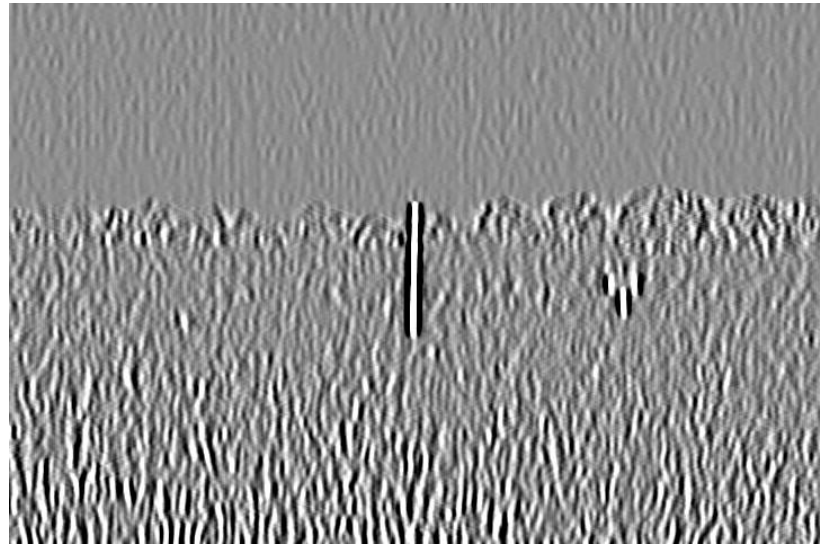
Figure 11. Filtered excess green image with modified